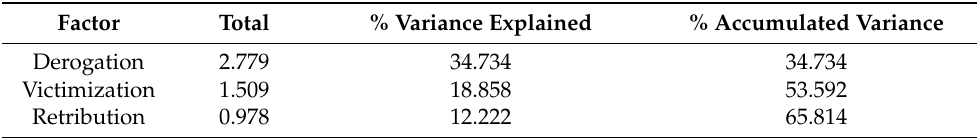
Table 2. Percentage of the variance explained by ABA-SF scale factors. Factor Total % Variance Explained % Accumulated Variance